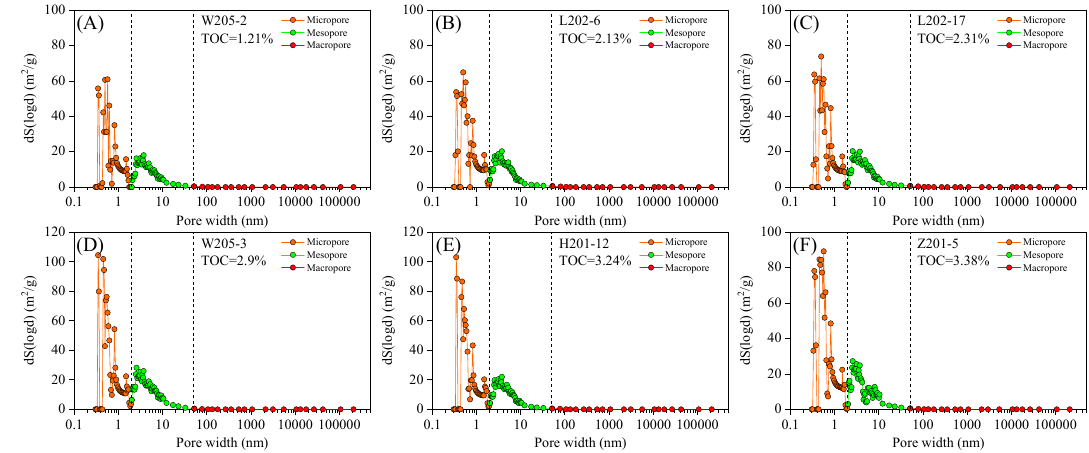
Figure 13. Combined PSDs curves of the specific surface area (SSA) based on the data from HMIP, N 2 and CO 2 adsorption experiments. (A) sample W205 ‐ 2; (B) sample L202 ‐ 6; (C) sample L202 ‐ 17; (D) sample W205 ‐ 3; (E) sample H201 ‐ 12; (F) sample Z201 ‐ 5.